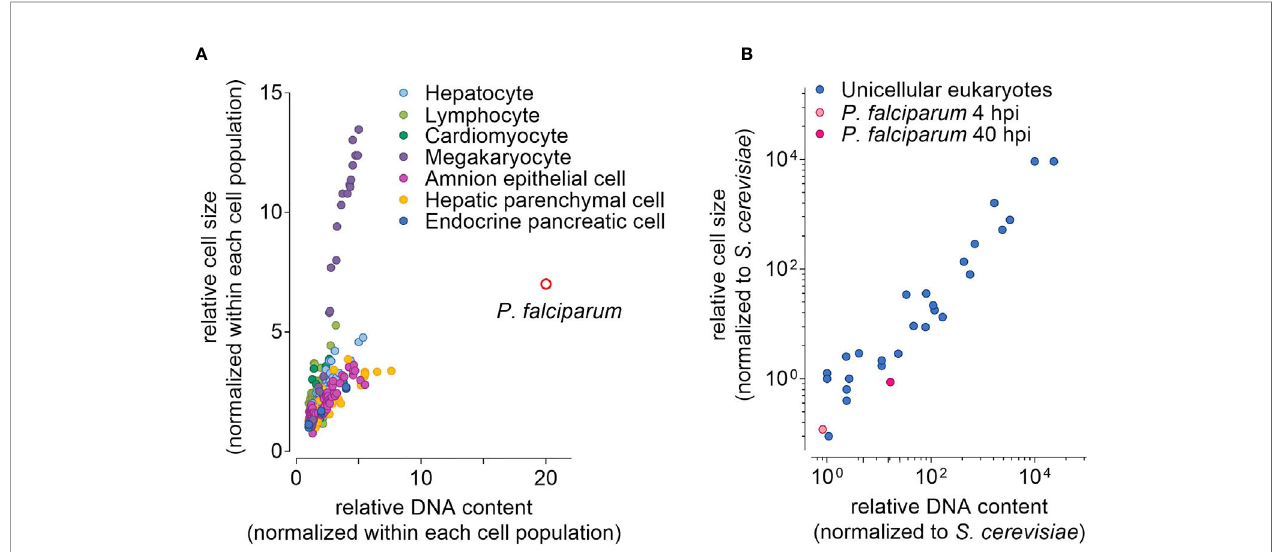
FIGURE 1 | Distribution of nuclear DNA content and cell volume in eukaryotic cells. (A) Relative DNA content and cell size of P. falciparum (40 hours post invasion, hpi, of an erythrocyte) and human cells with varying ploidy based on Gillooly et al., 2015. Each point represents the fold increase in cell size and DNA content relative to the smallest cell with the lowest DNA content of each population. (B) Relative DNA content and cell size of 25 species of unicellular eukaryotes in G1 phase based on Table 2 from Shuter et al., 1983. Here, the relative cell size and DNA content was normalized to the Saccharomyces cerevisiae . Note: Values for P. falciparum were derived as follows: estimated DNA content before DNA replication in femtogram reported by Mangold et al., 2005; ploidy level based on Ganter et al., 2017 and Simon et al., this issue; cell volume estimated from Waldecker et al.,